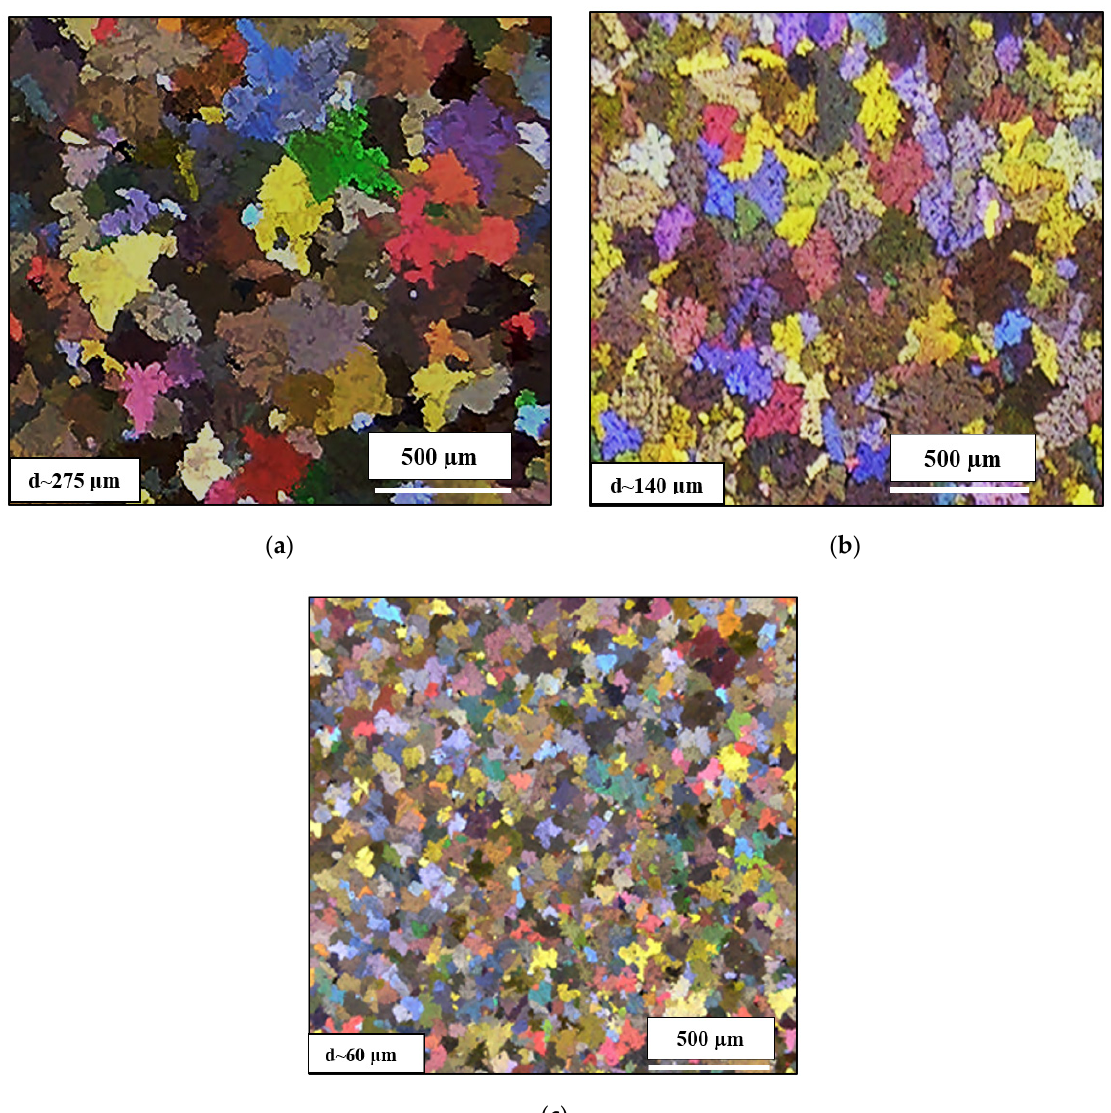
Figure 3. Optical macrographs and average grain sizes of the as-cast microstructure in the ( a ) 220A, ( b ) 220L and ( c ) 220M alloys.